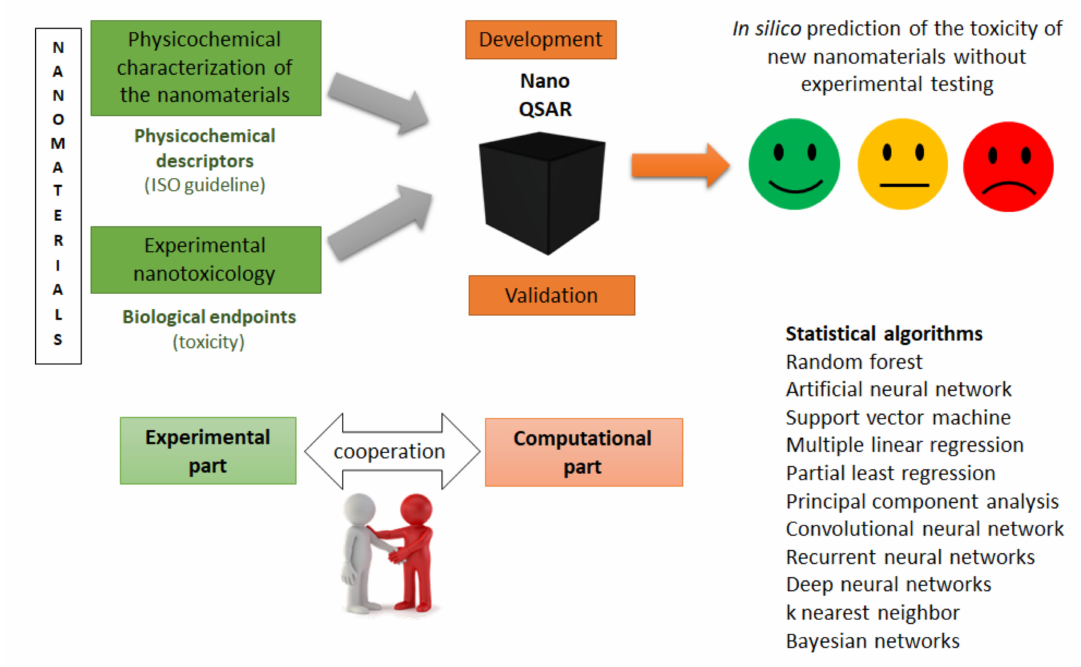
Figure 3. The development of QSAR models for the prediction of nanomaterial toxicity can use various statistical algorithms and is based on nanodescriptors (physicochemical features of nanoma- terials) and biological endpoints (toxicity), both experimentally determined. This approach argues for strong collaboration between experimenters and